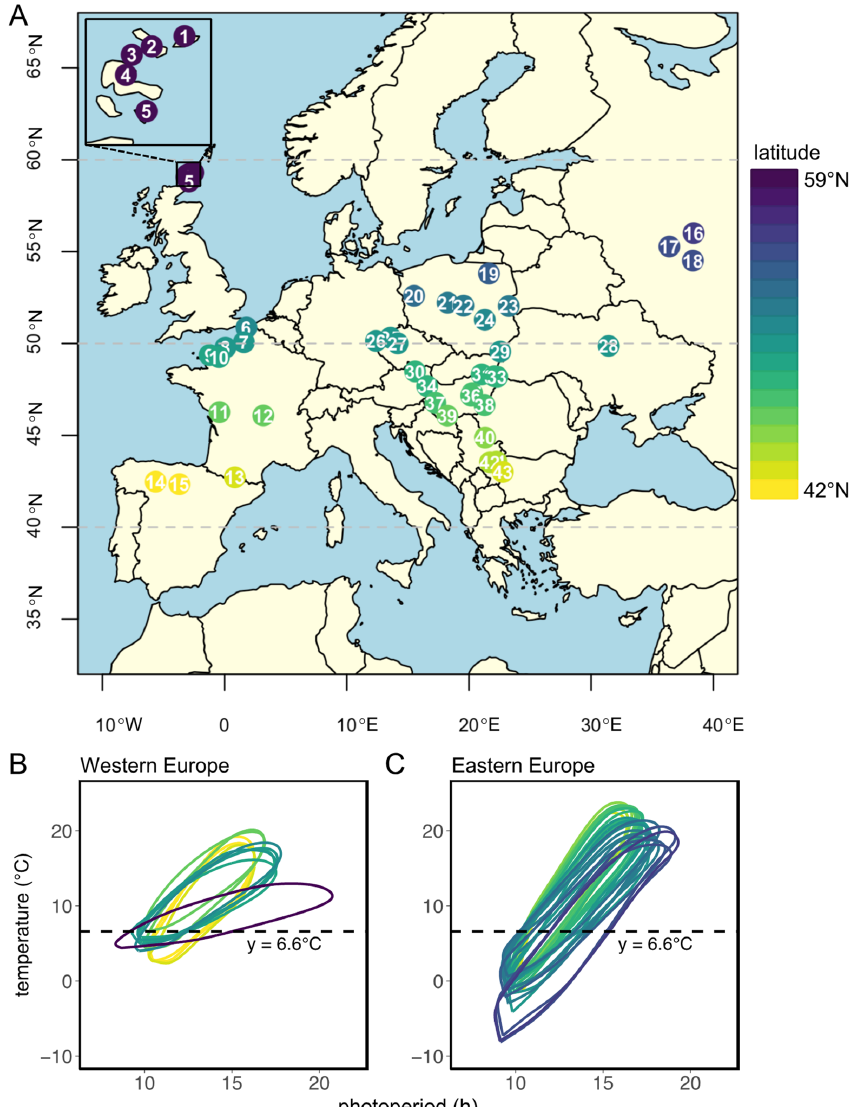
Figure 1. Sample locations and local annual photoperiod–temperature ellipsoids. ( A ) Distribution map of localities of common vole samples used in this study. Location numbers with corresponding environmental proxies are listed in Table S1. ( B ) Annual patterns (counter-clockwise) of photoperiod and 10-year average monthly ambient temperature for each sample location in Western Europe and ( C ) in Eastern Europe. Temperature data were obtained from the closest weather station (always within 110 km of sample location) obtained from Wunderground (https://www.wunderground.com/ (accessed on 7 December 2022)). Photoperiod was obtained from https://www.timeanddate.com (accessed on 7 December 2022) and is based on civil twilight times at dawn and dusk, which is the timing at which log light intensities change most rapidly [5,48]. Civil twilight incorporates geographical and seasonal variation in the duration of twilight [49] and is, therefore, considered as the moment of ‘lights on’ and ‘lights off’ for biological systems [5]. Dotted lines indicate a temperature threshold at 6.6 ◦ C, from which the corresponding predicted critical photoperiod (pCPP) in spring (ellipse crossing the 6.6 ◦ C line for the second time) is used as a proxy for onset of grass growth and, consequently, as a proxy for onset of the favorable season. Regional pCPPs are listed in Table S1. Colors indicate latitude, ranging from 42 ◦ N (yellow) to 59 ◦ N